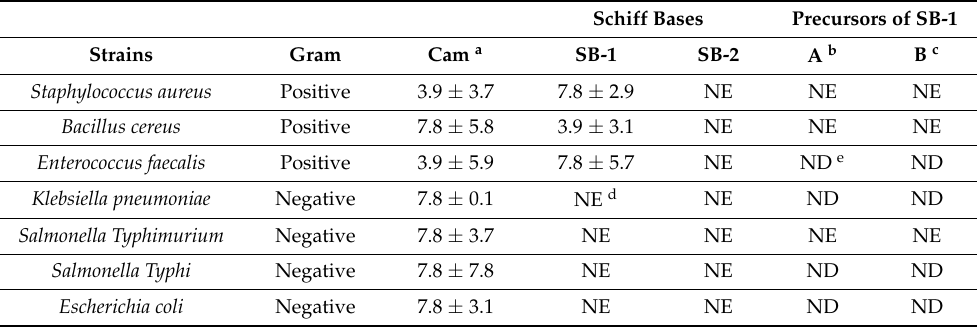
Table 2. Minimal inhibitory concentration (MIC) ( µ M) of SB-1, SB-2, and precursors for SB-1 (called A and B). Bacteria were cultured for 24 h before MIC determination ( n = 3). Schiff